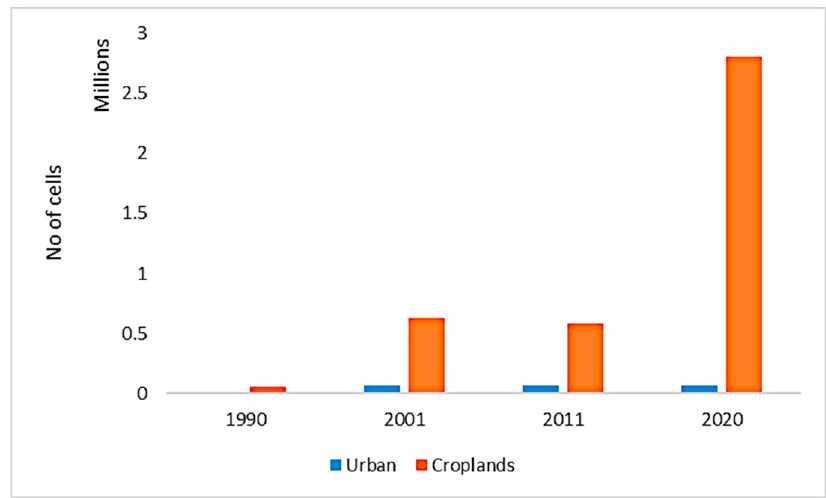
Figure 10. Number of cells for the urban/settlement and croplands land cover classes within the Anole wells cluster shows increasing areal coverage through the years.